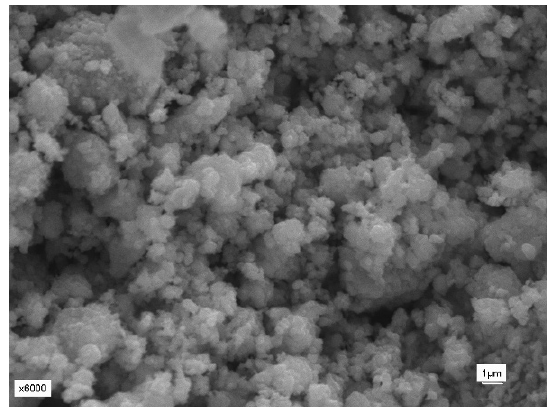
Figure 4. SEM image of ZnO powder mechanically activated at 500 rpm, 10 h milling time.